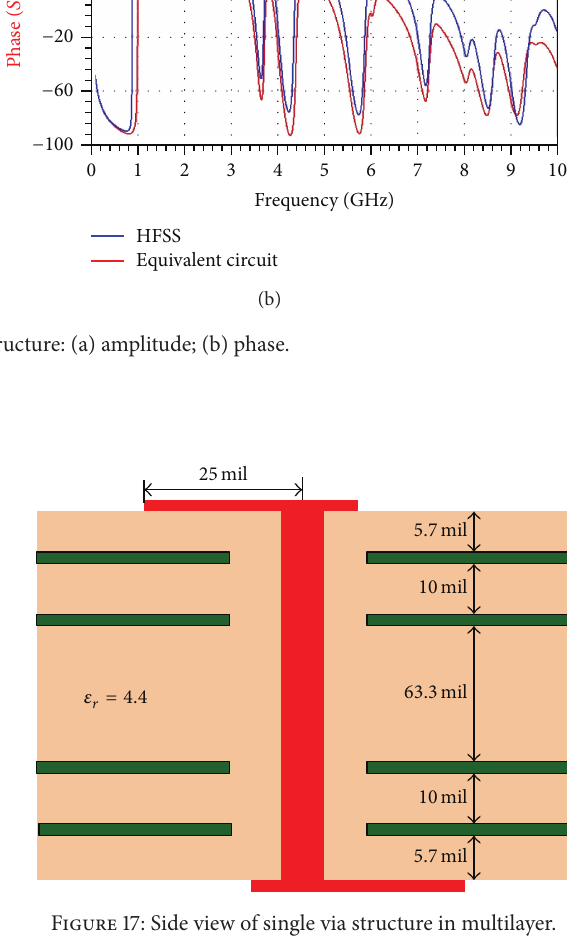
Figure 17: Side view of single via structure in